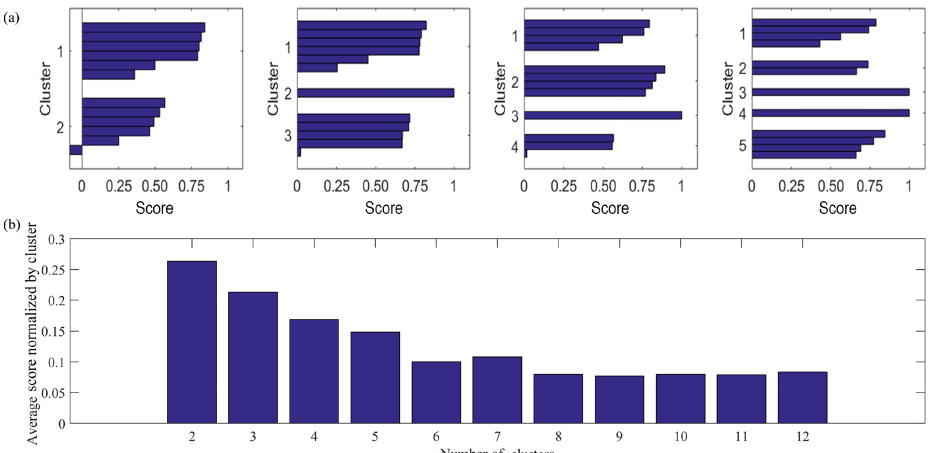
Figure 6. (a) Scores for each cluster analysis of the GISS model data in the North Atlantic for k = 2, k = 3, k = 4, k = 5, where cluster k is the predetermined number of clusters and each bar represents the score per 2-D histogram. (b) Average scores for each cluster analysis with increasing k , normalized by the number of clusters k .